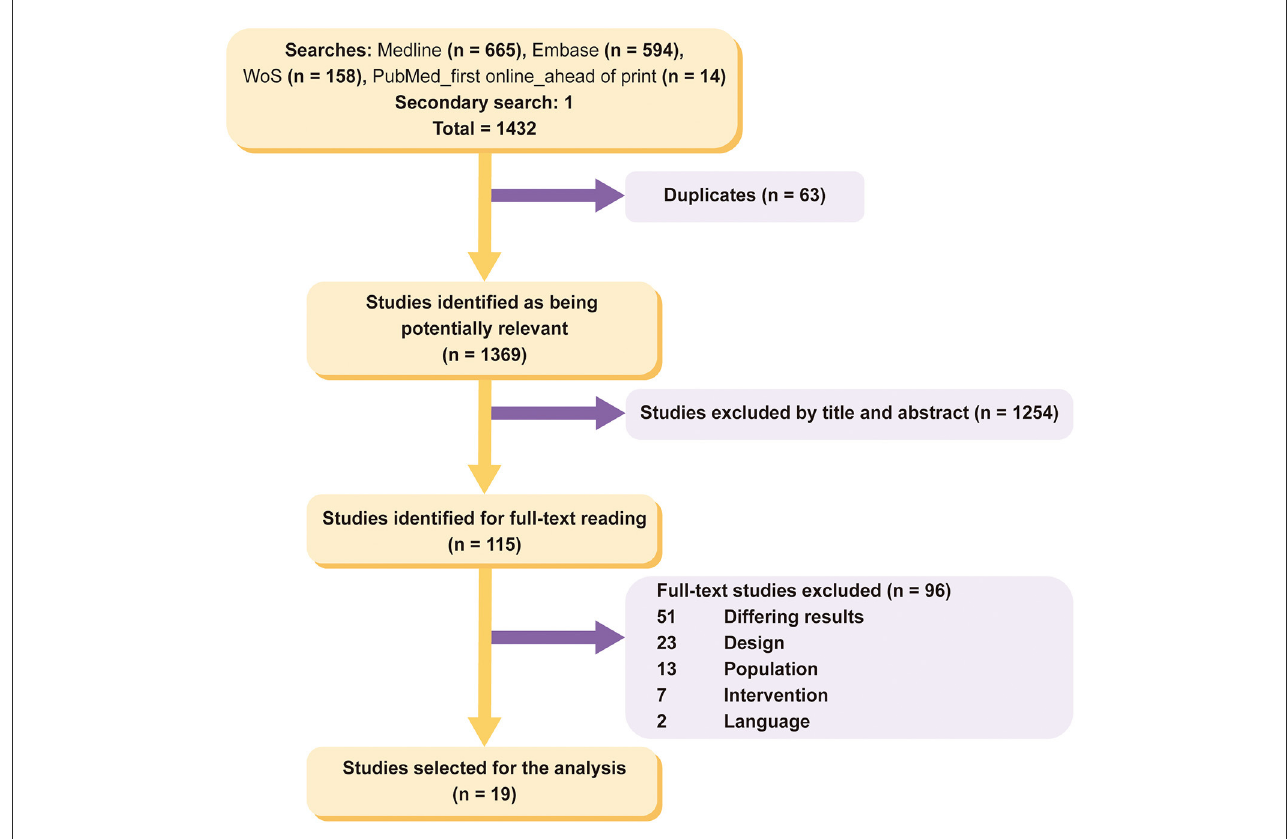
FIGURE1 PRISMA flowchart.